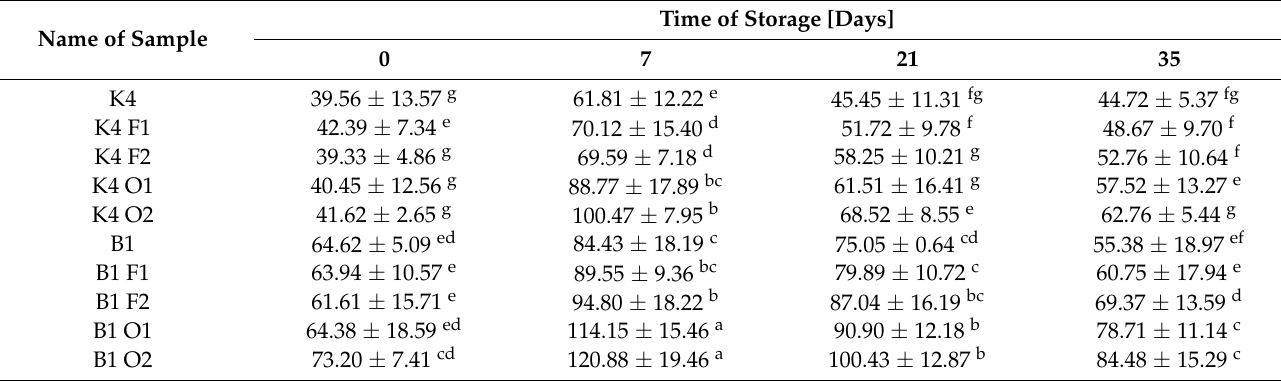
Table 2. Changes in the viscosity values ± SD (mPa · s) for fermented milk samples during storage.